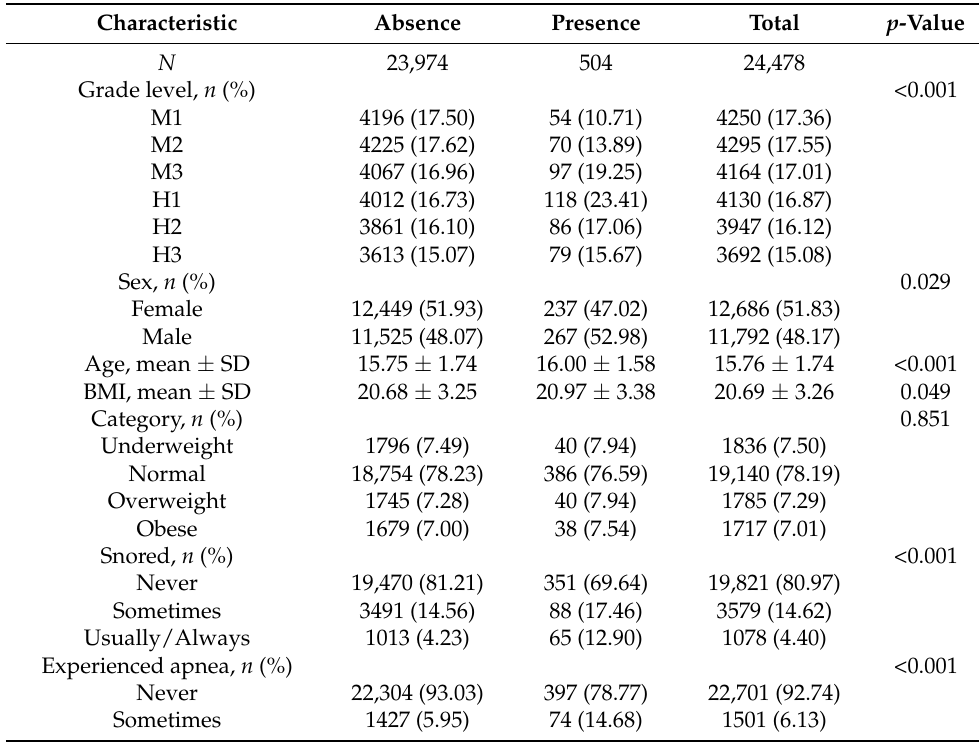
Table A1. The characteristics according to self-perceived PLMS in participants in the absence of restless legs